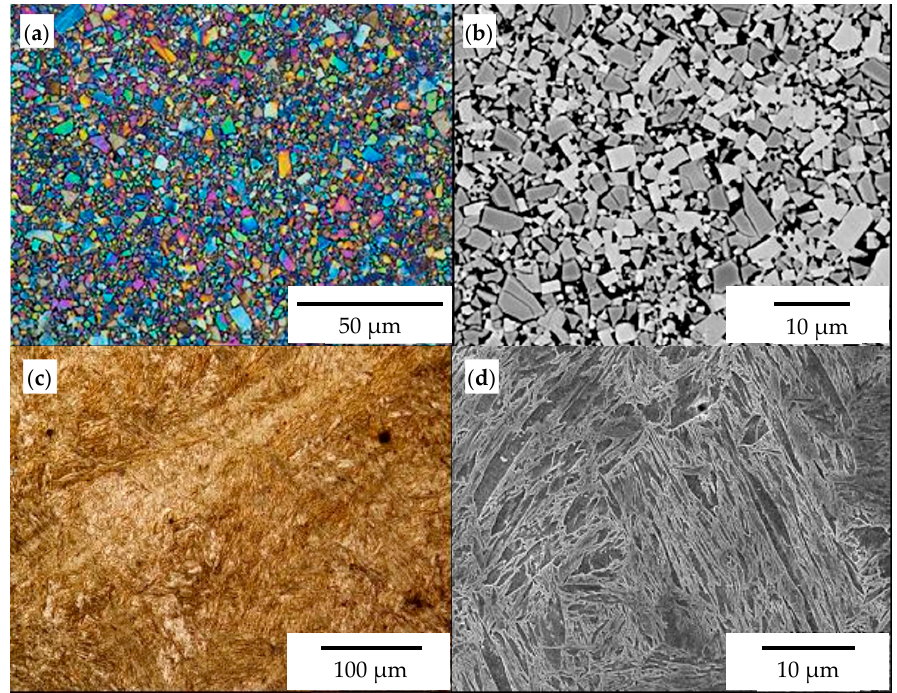
Figure 7. The microstructure of materials used for chisels B: ( a ) cemented-carbide plate (LM), ( b ) visible fine grains of tungsten carbide in a cobalt matrix (SEM, BSE detector), ( c ) microstructure of the base material (LM), ( d ) visible medium-carbon tempered martensite (SEM, SE detector).